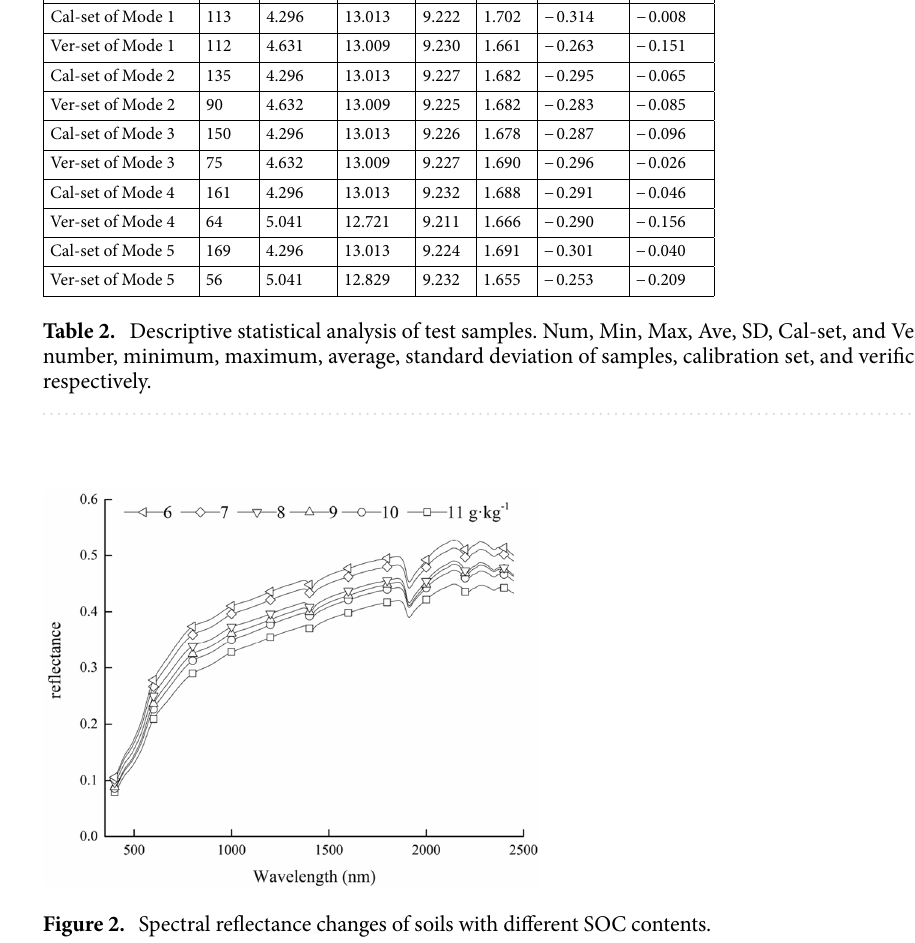
Figure 2. Spectral reflectance changes of soils with different SOC